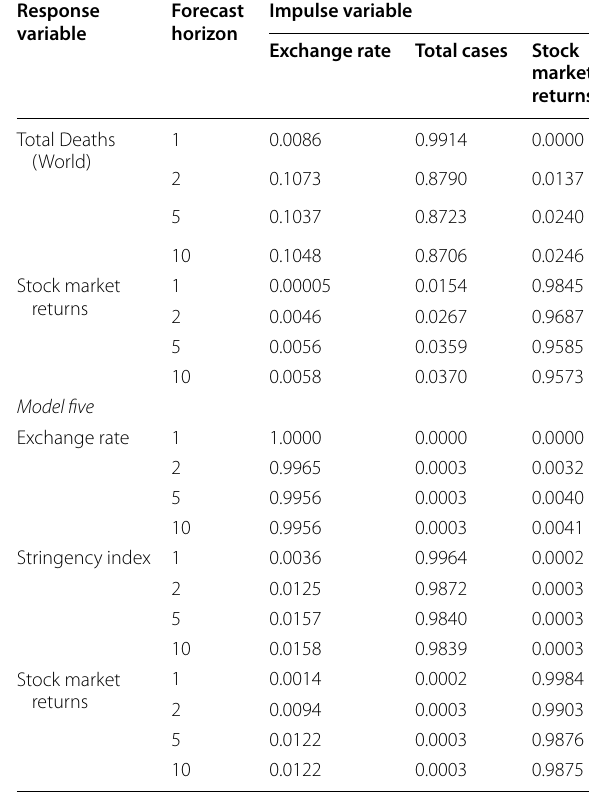
Table 8 Forecast error variance decomposition